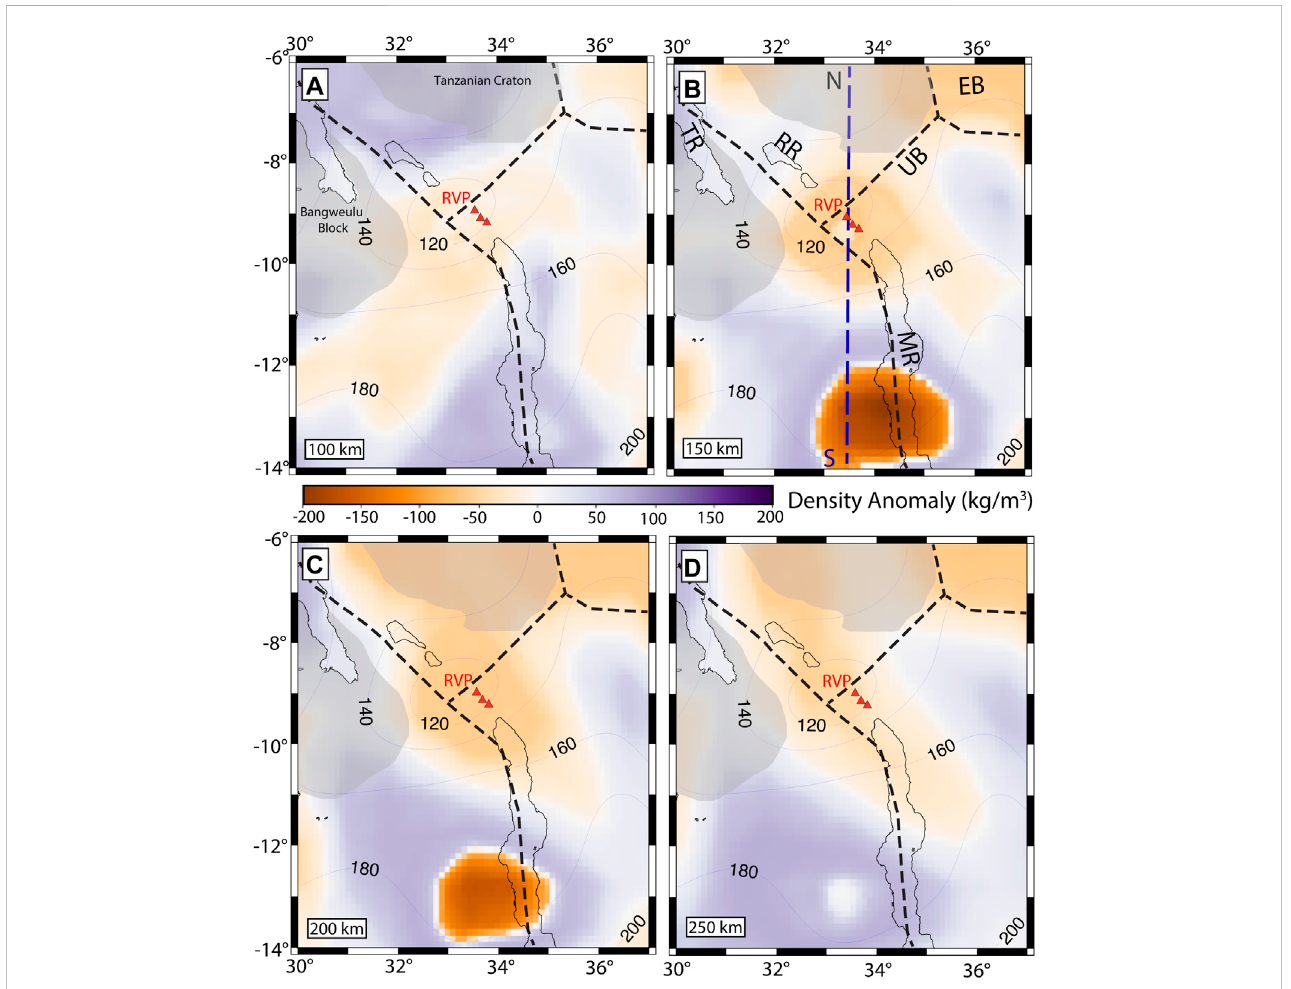
FIGURE 4 Depth slices showing in situ density anomalies beneath the RVP and surroundings at (A) 100 km, (B) 150 km, (C) 200 km and (D) 250 km depth. Red trianglesrepresenttheRungweVolcanicProvince(RVP).Blacklinesindicatetheoutlineofriftlakes.Bluecontoursshowlinesofequallithosphericthicknessat 20 km intervals from Fishwick (2010). Black dotted lines delineate plate boundaries from Stamps et al. (2008). Blue pro fi le N-S in Figure 4B is the pro fi le location for Figure